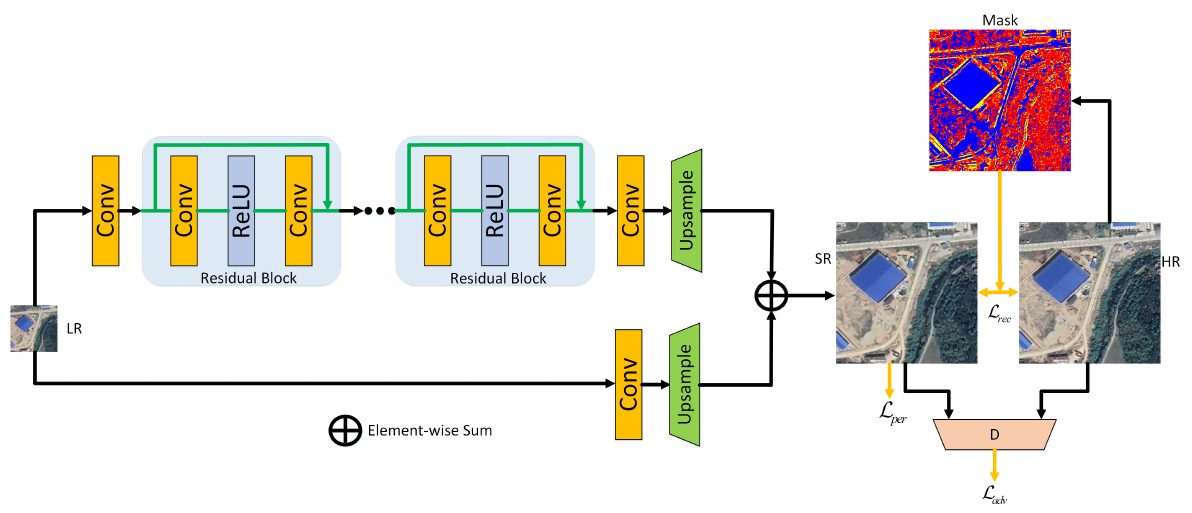
Figure 2. Architecture of the enchanced WDSR network.